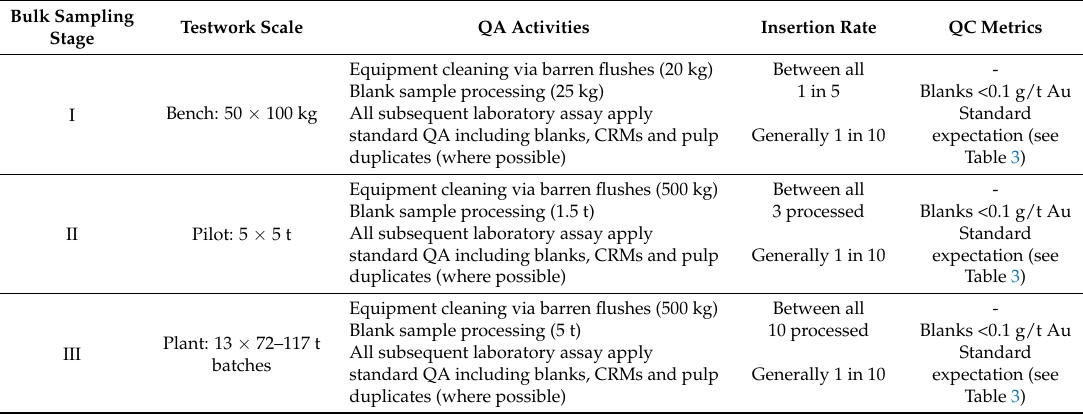
Table 12. Summary of bulk sampling programme QAQC.